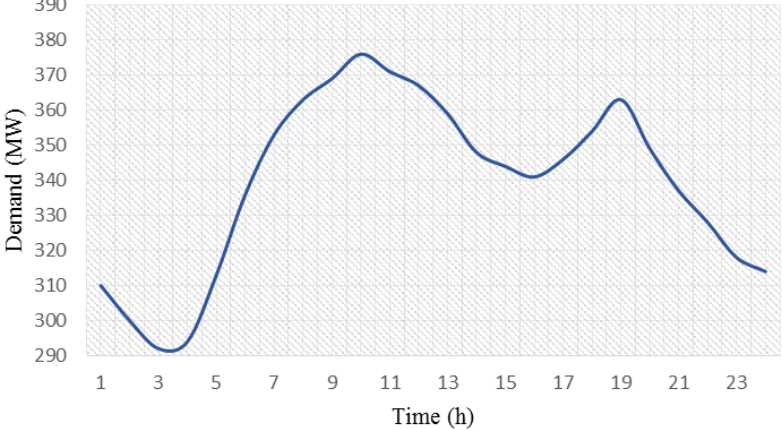
Figure 12. The load demand curve for the 30-bus system—24 h ahead.